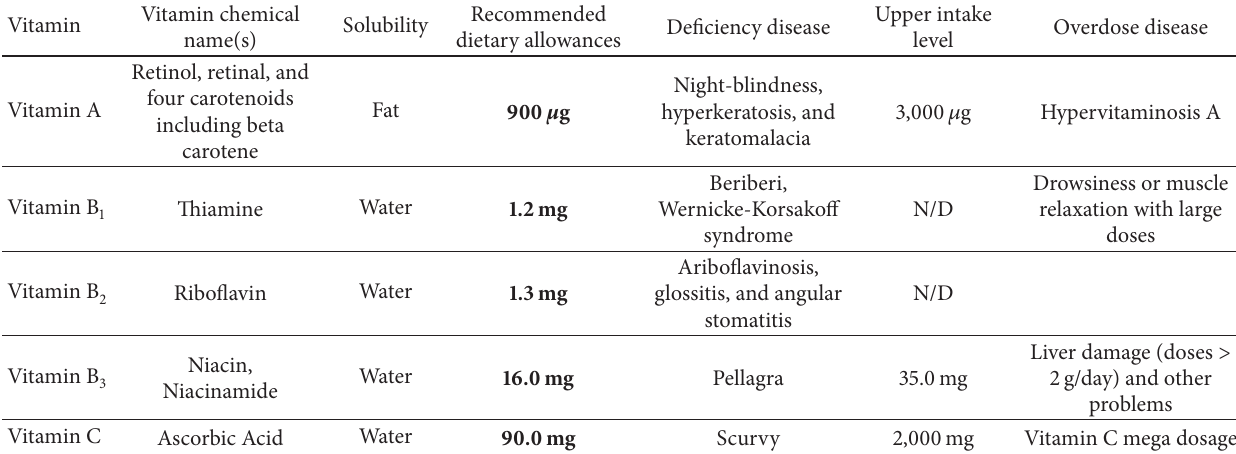
Table 10: The model used while creating the subclasses and individual entries of some well-known vitamins in the FOKB.